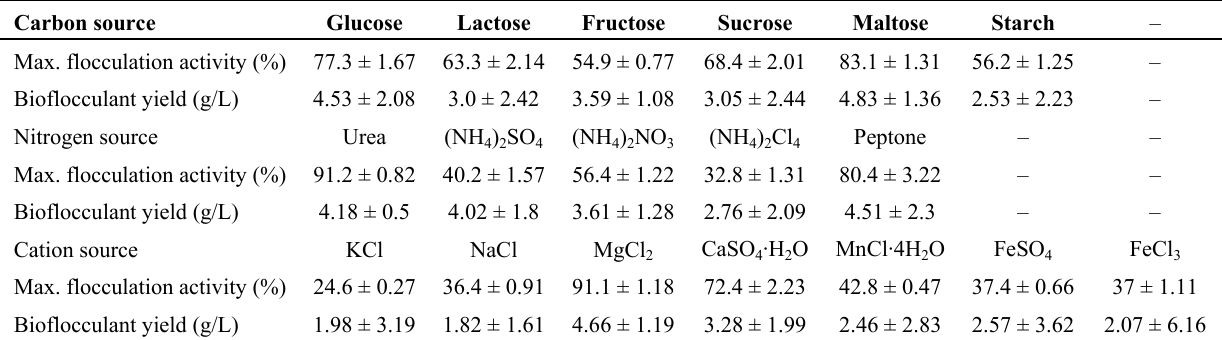
Table 1. The effects of nutritional factors on bioflocculant production by Brachybacterium sp. (UFH)